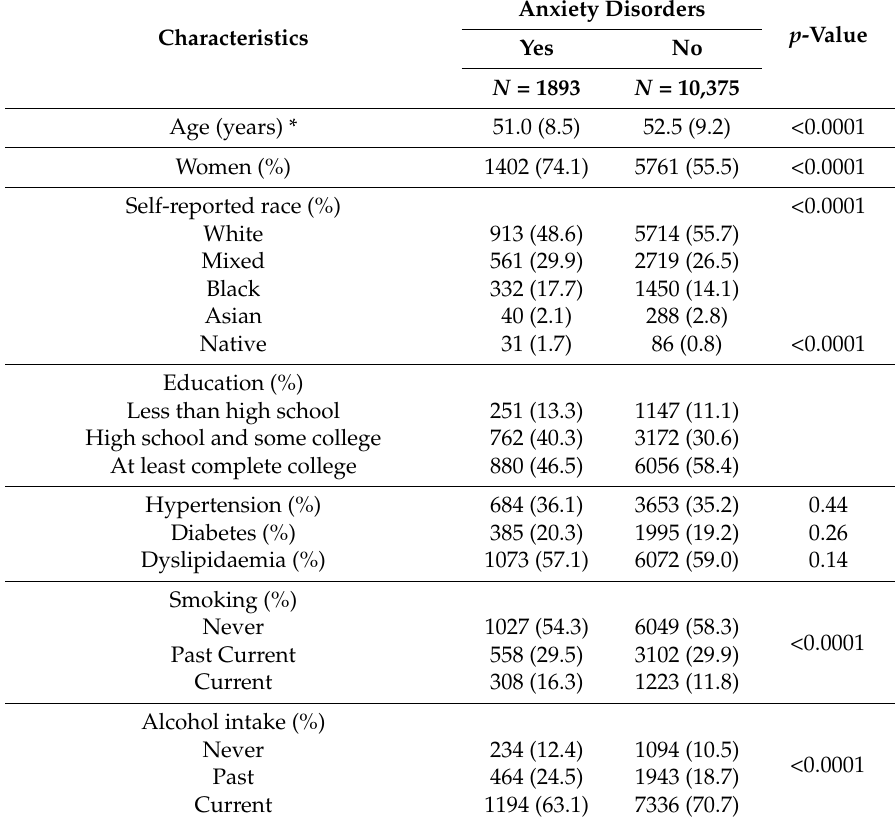
Table 1. Clinical characteristics of participants according to the presence or absence of anxiety disorders. ELSA-Brazil,